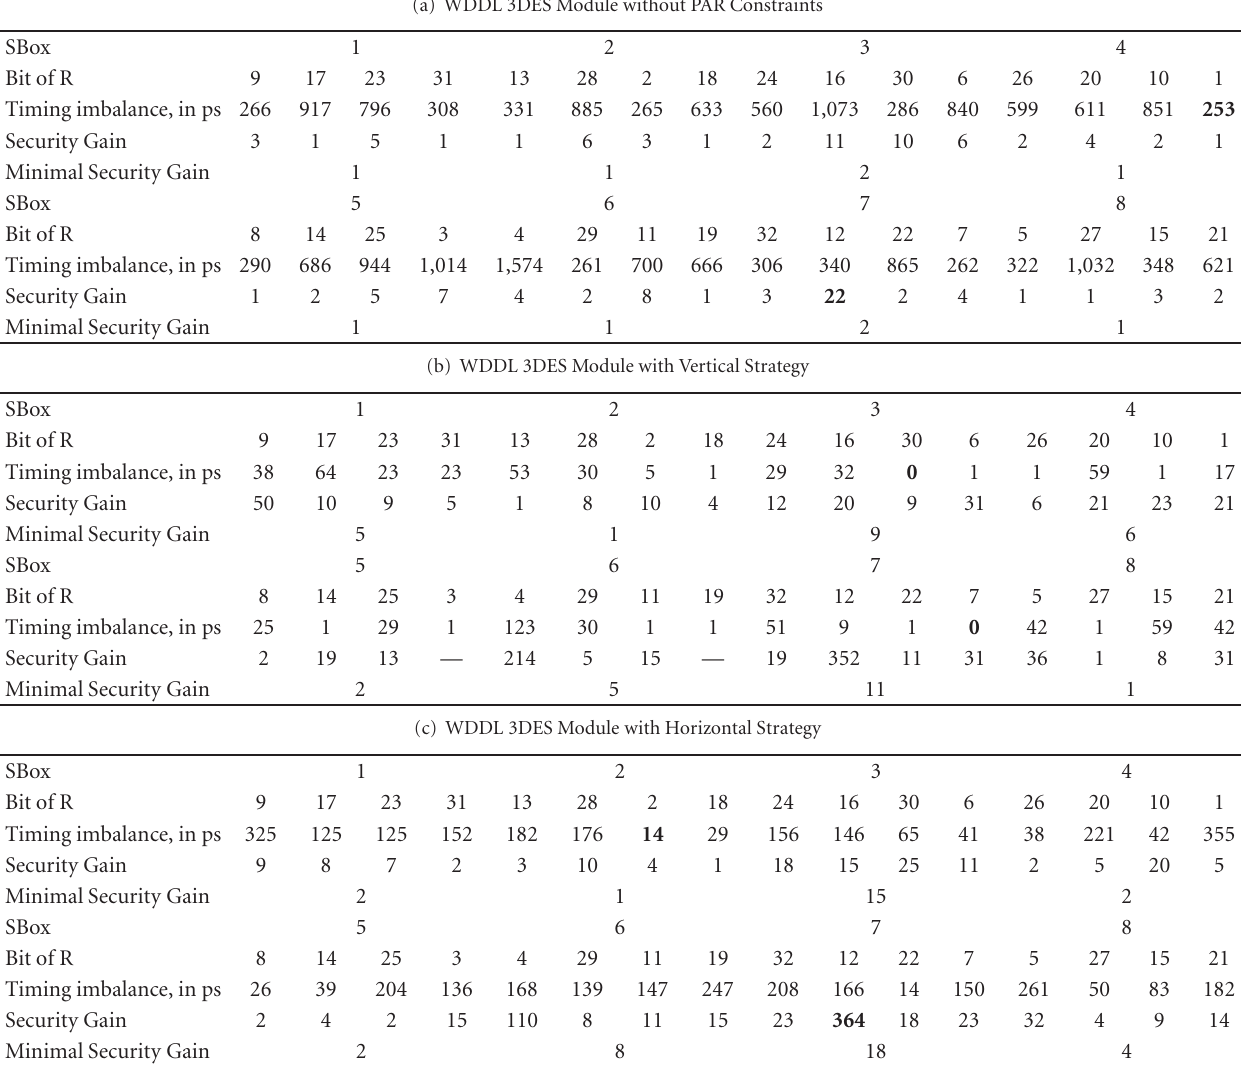
Table 3: Statistics for Bits of R S